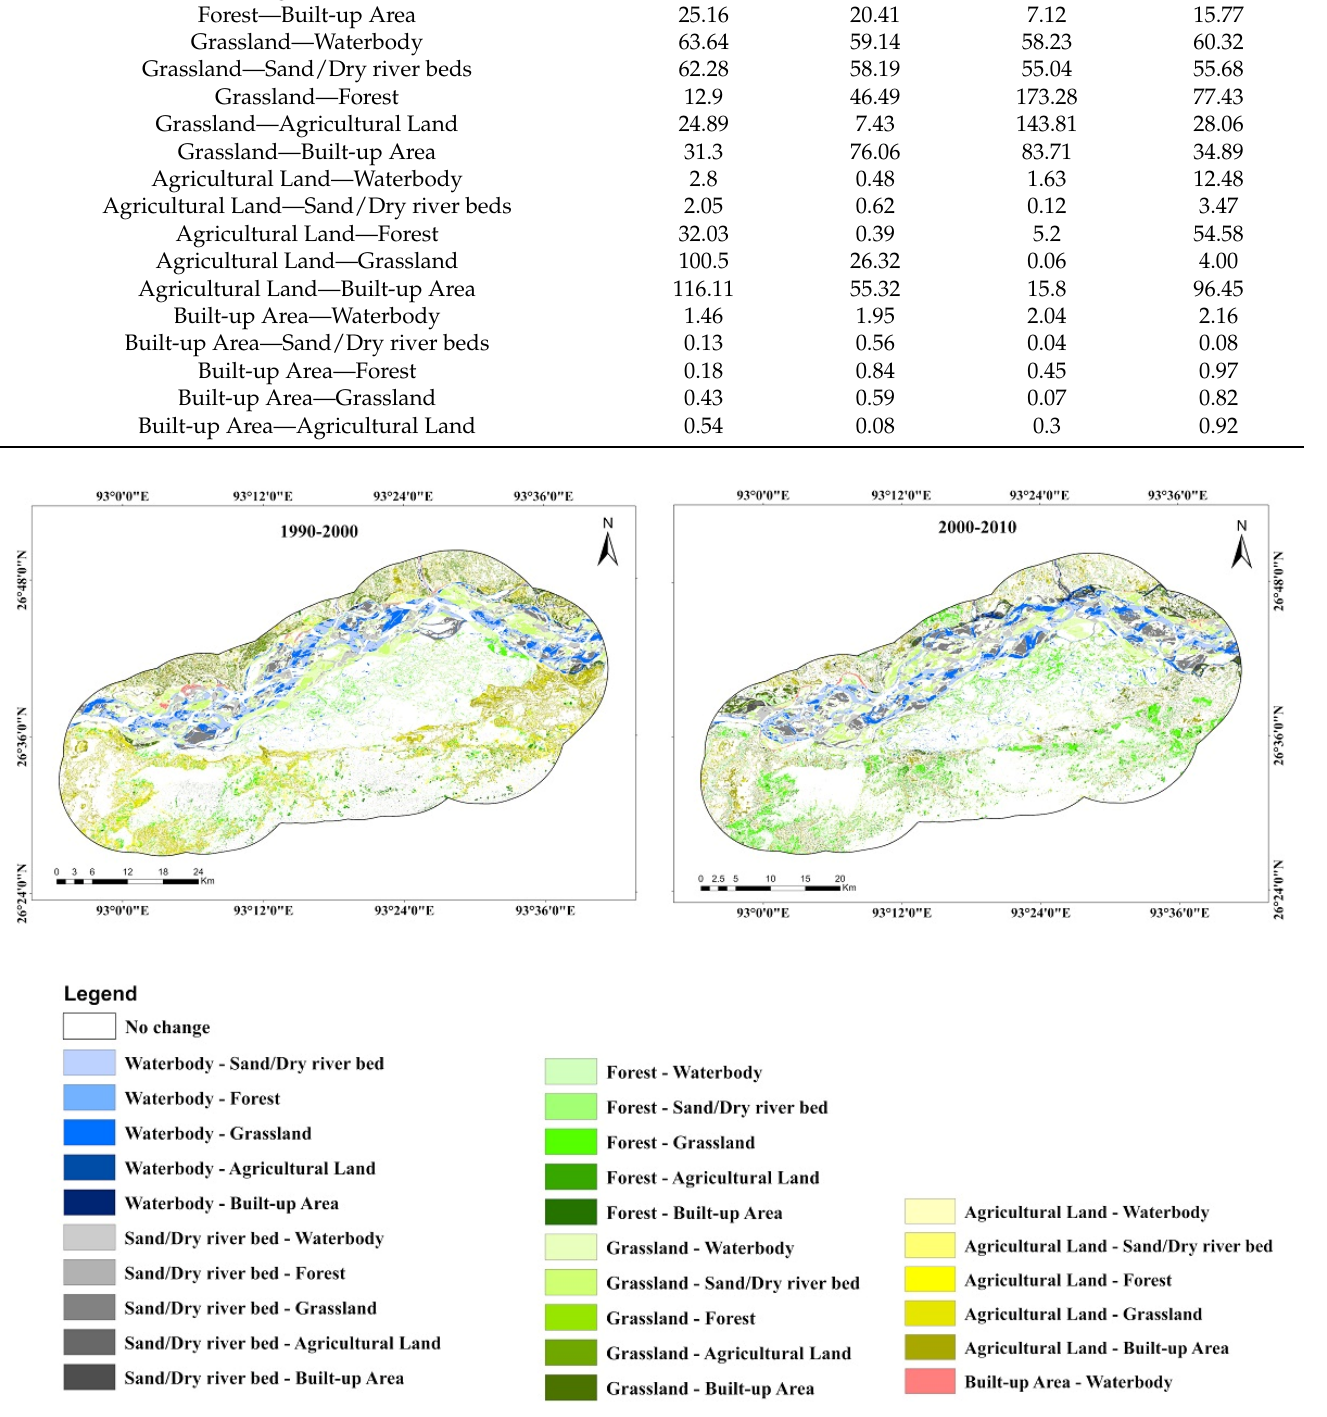
Figure 6. Change map of different LULC classes between 2000–2010 and 2010–2020.